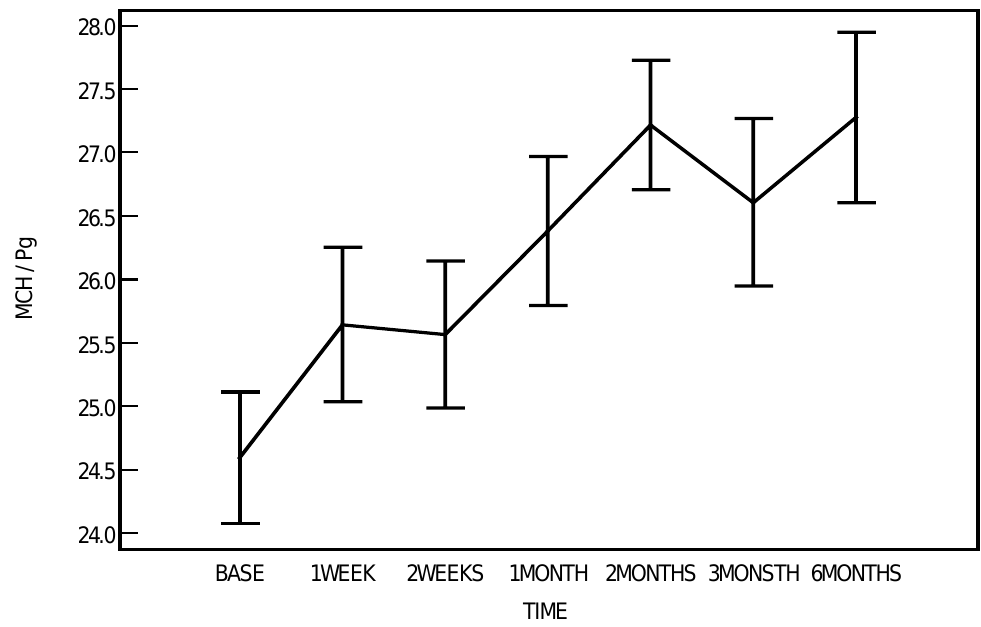
FIGURE 6. Increase in red blood cell MCH following infusion of the RSC into patients with beta-thalassemia. Artificial values at baseline due to recent transfusion.